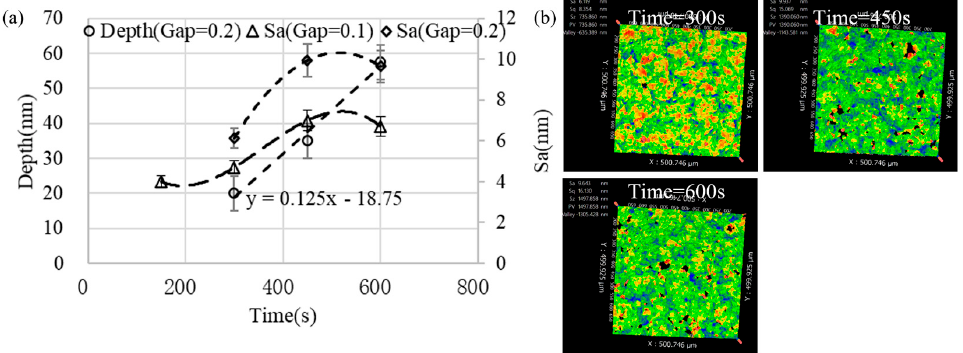
Figure 13. The removal pit changes with processing time: ( a ) the depth and the bottom surface roughness and ( b ) the bottom surface morphology (amplitude = 40 μ m, gap = 0.2 mm).